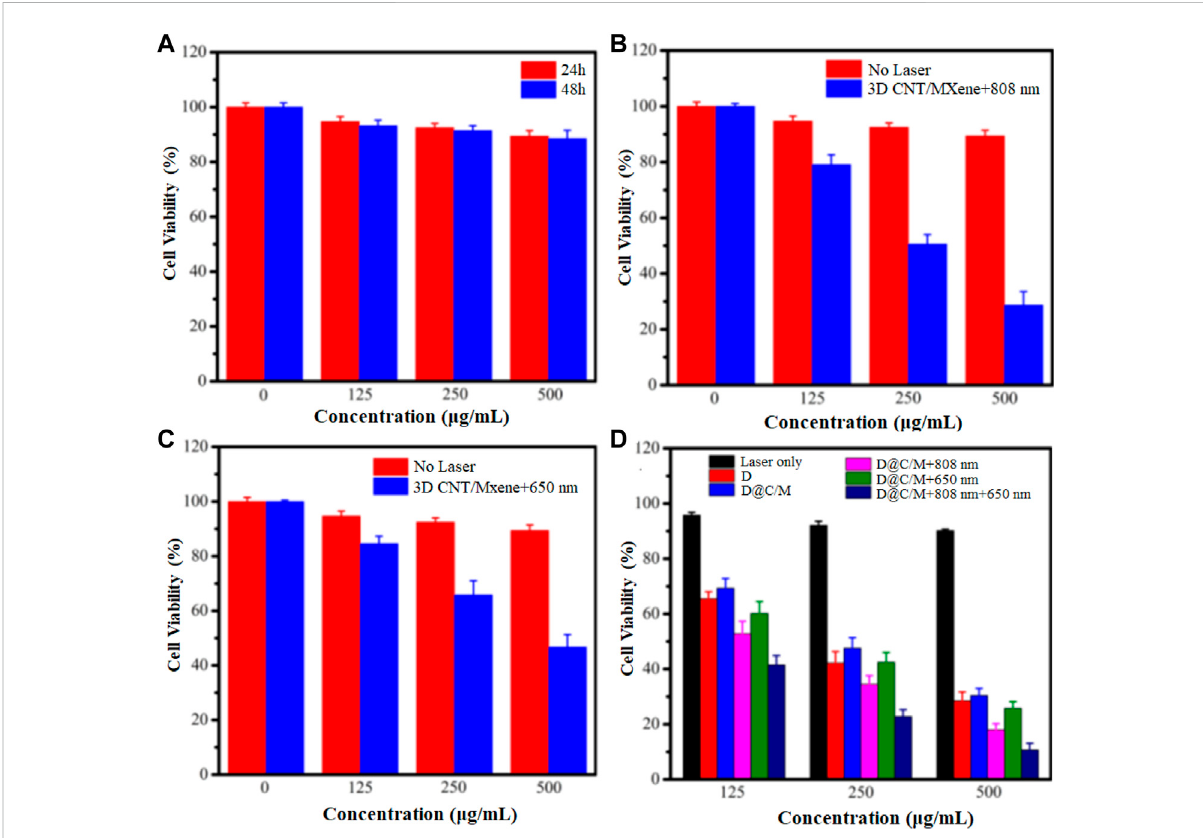
FIGURE 10 Viability of HeLa cells with varying concentration of 3DCNT/MXene indifferent environments (A) HeLa cells incubatedwith 3D CNT/MXene for 24 and 48 h; (B) HeLa cells incubated with 3D CNT/MXene without and with 808 nm laser irradiation; (C) HeLa cells incubated with 3D CNT/MXene at 650 nm laser irradiation; (D) HeLa cells incubated with 3D CNT/MXene with laser irradiation only, DOX only, D@C/M (D: DOX, C/M: 3D CNT/ MXene), D@C/M+808 nm, D@C/M+650 nm, and D@C/M + 808 nm + 650 nm. The incubation time was 24